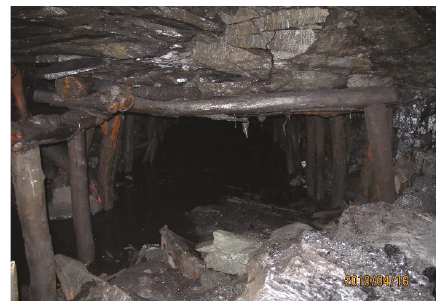
Figure 9: Timber support in the No.1 abandoned tunnel.